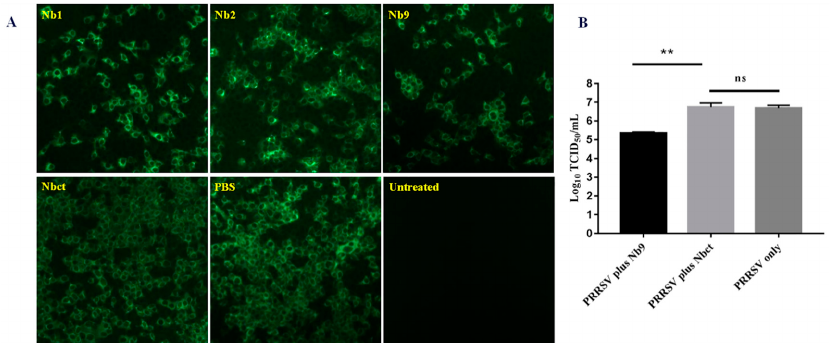
Figure 6. Antiviral effects of cell-penetrating peptide delivered Nb proteins on PRRSV replication. Marc-145 cells were infected with PRRSV JK100 at MOI of 0.01 for 1 h and treated with 80 µ M each Nb. At 48 hpi, the cells were fixed for indirect immunofluorescence assay (IFA) using PRRSV N-specific mAb, followed by FITC-conjugated goat anti-mouse IgG (magnification, 200×) ( A ). Additionally, cultures were harvested for titration of progeny viruses (**, p < 0.05; ns, not significant, p > 0.05) ( B ).